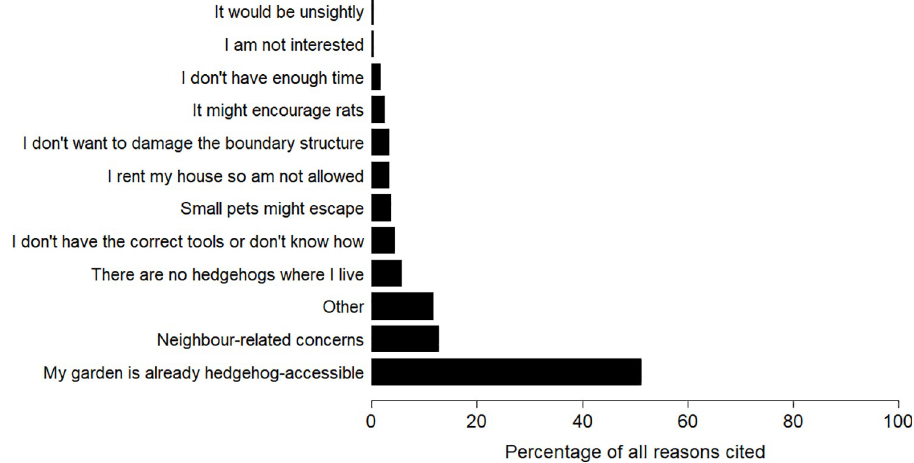
Fig 5. Reasons given by householders for not having created a hedgehog highway at the time of surveying. Figures are the percentage of all 4779 reasons cited by 3141 respondents.